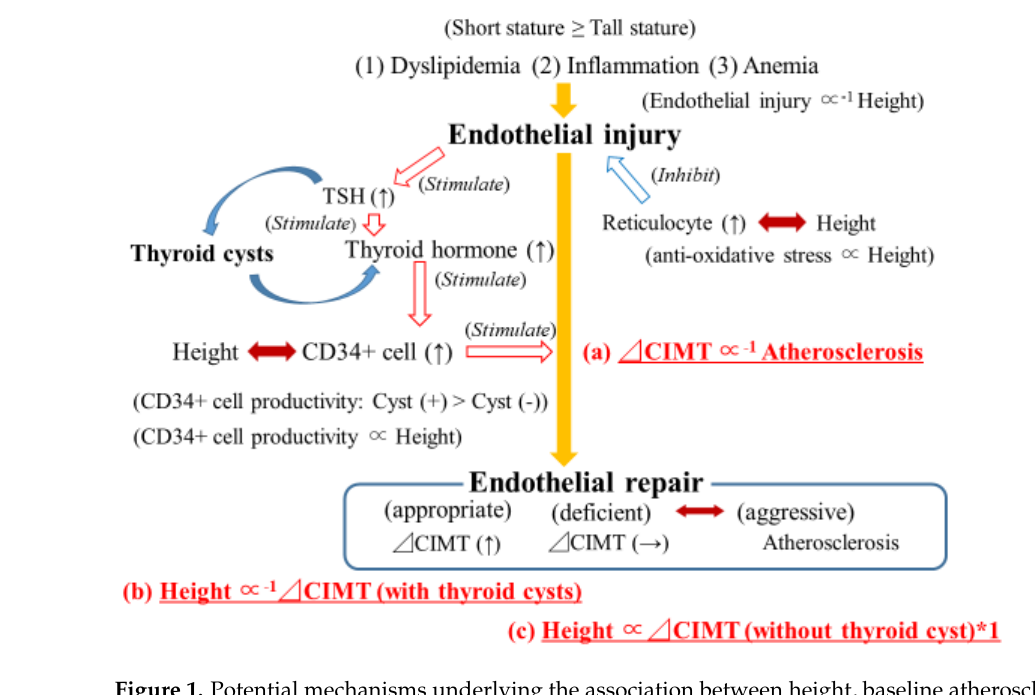
Figure 1. Potential mechanisms underlying the association between height, baseline atherosclerosis, and active arterial wall thickening. Atherosclerosis: baseline atherosclerosis. CIMT: carotid intima- media thickness. ⊿ CIMT: active arterial wall thickening. Associations coded in red were identified in the present study ( a – c ). *1: The association was not statistically significant.